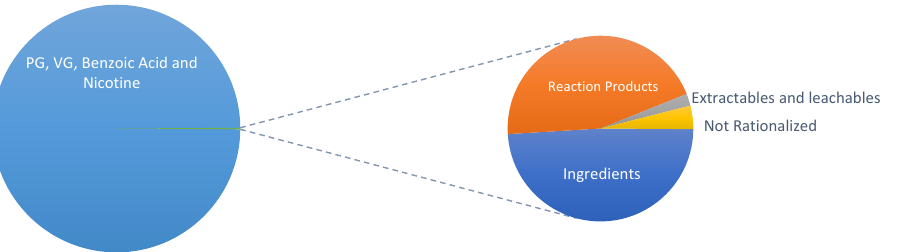
Figure 5. % Total Mass of Constituents by Type in Aerosol of VT5 Under the Intense Puffing Regimen.